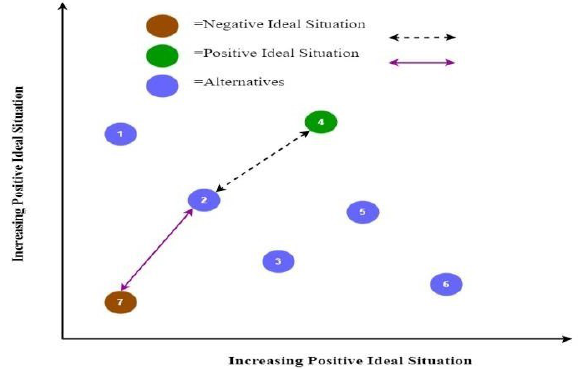
Figure 3. Negative and positive